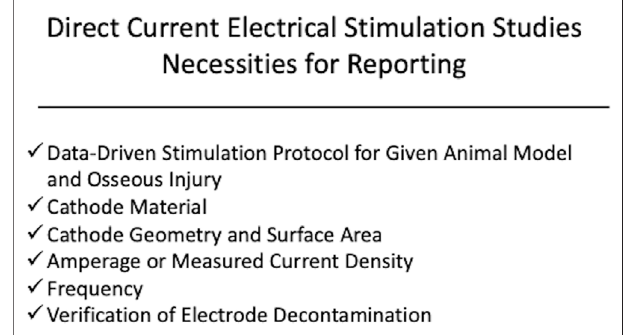
FIGURE 1 | Displayed is a schematic demonstrating the recommended components for device speci fi cations and stimulation protocol for apreclinical direct current electrical stimulation (DCES) study. The authors recommend reporting cathode material, current density, cathode geometry, frequency, and veri fi ed electrode decontamination and applying a stimulation protocol based on successful outcomes from prior studies within the context of the osseous injury being